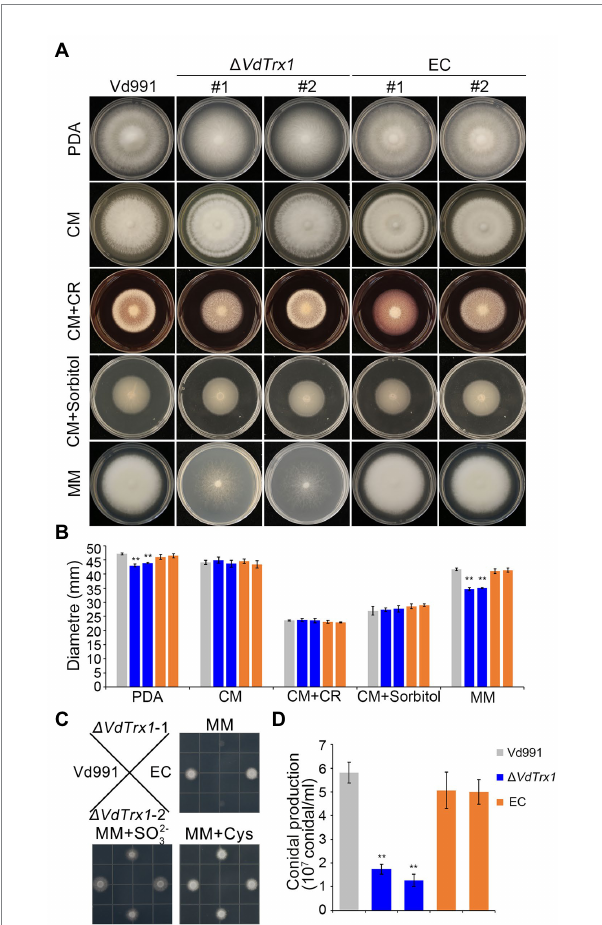
FIGURE 6 VdTrx1 is essential for sulfite assimilation and conidiation in V. dahliae . (A) Radial growth of VdTrx1 deletion strains, complemented strains (EC#1 and #2) and wild-type strain (Vd991) on different media after incubation at 25 ° C for 12 days. A 2 μ l conidial suspension (5 × 10 6 conidia/ml) was placed in the center of the plates as inoculum. (B) Colony diameter of the different strains on different media after 12 days of incubation. Means and standard deviations from three biological replicates are shown. Double asterisks indicate significant differences at p < 0.01. (C) Growth of V. dahliae strains on plates with different source of sulfate. The various V. dahliae strains were inoculated on MM plates, or MM plates supplemented with 2 mM sulfate ( SO 32 − ) and 1.4 mM cysteine (distribution of strains on the plate are indicated in figure). The strains were cultured at 25 ° C for 4 days. (D) Quantification of conidial production was based on a 5-mm-diameter PDA agar plug from the edge of 9-days-old fungal culture colonies in 1 ml water. The error bars represent the standard deviations of the mean (n = 3). Student’s t -test was employed to determine treatment differences and double asterisks indicate significant differences at p <